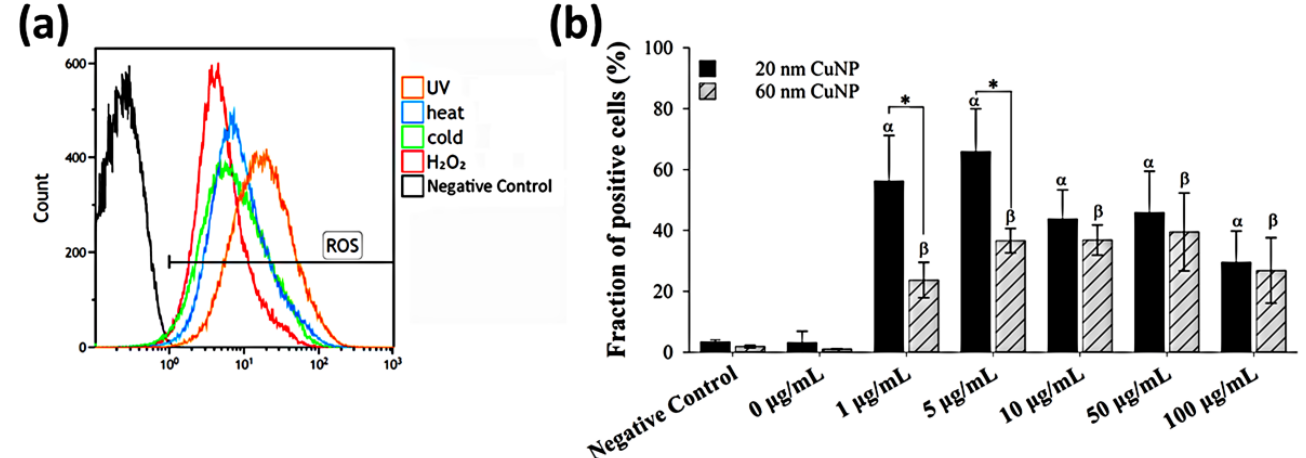
Figure 4. ROS generation in E. coli after CuNP treatment. ( a ) Flow cytometry analysis of ROS induced by various inducers in E. coli . Four groups of bacteria were subjected to the following conditions to induce ROS: 405 nm UV light for 3 h, 45 °C for 2 h, 4 °C for 2 h, and 3% H 2 O 2 for 30 min. Bacteria cultured under normal conditions (37 °C, LB medium) and then washed with PBS served as the negative control. H 2 DCFDA was applied to bacteria to detect ROS. ( b ) Fractions of fluorescent positive cells in different CuNP treatments. Bacteria were treated with two sizes of CuNPs in different concentrations for 24 h and then stained with H 2 DCFDA. Fluorescence was detected by flow cytometry. These data are presented as mean ± SD from five independent experiments performed in triplicate for each treatment group. Statistical comparisons were performed by Student’s t -test; α and β indicate p < 0.05 for 20 and 60 nm CuNP treatments relative to the negative control, respectively, and * indicates p < 0.05 for the comparisons between 20 and 60 nm of CuNPs.